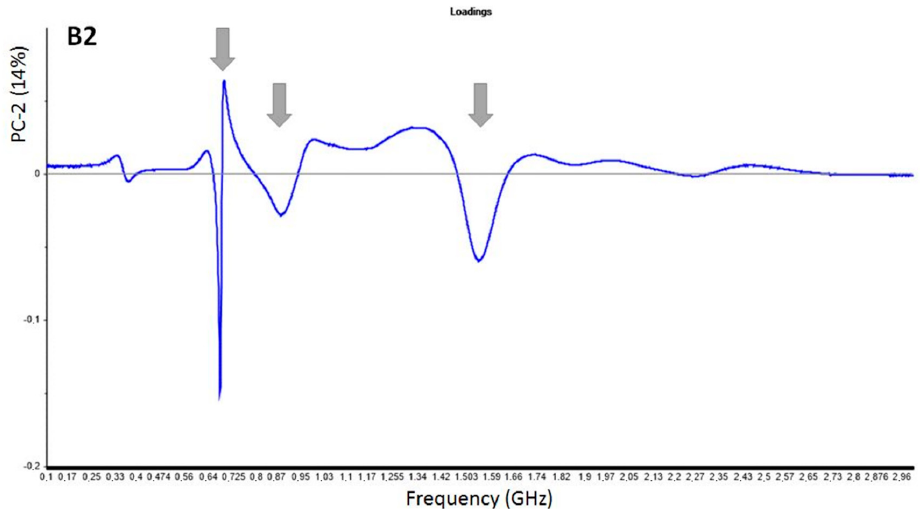
Figure 6. ( A ) Detection of iprodione in a white wine sample using the microwave sensor coupled to MIS. Iprodione concentrations varied from 5 to 250 ng L − 1 . PCA scores plot of 30 white wine samples. PC1 and PC2 account for 95% of the total variance in the data. ( B1 ) Detection of iprodione in a white wine sample using the microwave sensor coupled to MIS. Loading plot for the first principal component (PC1). Characteristic bands are highlighted by arrows. ( B2 ) Detection of iprodione in a white wine sample using the microwave sensor coupled to MIS. Loading plot for the second principal component (PC2). Characteristic bands are highlighted by arrows.